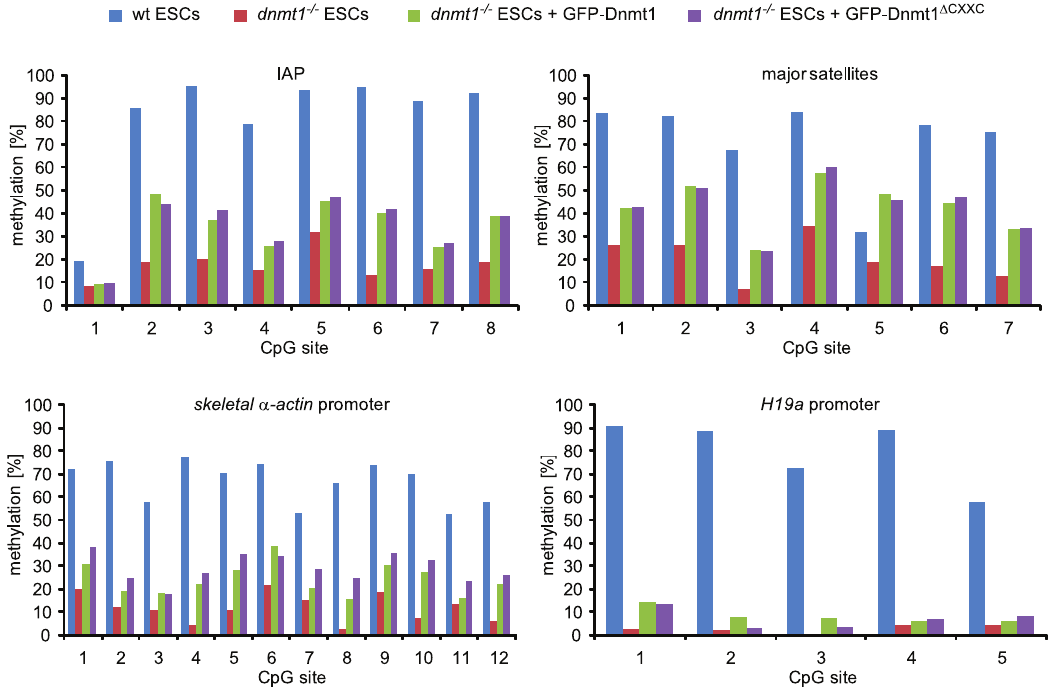
Figure 6. The CXXC deletion construct of Dnmt1 restores methylation in dnmt1 null cells. Mouse dnmt1 2 / 2 ESCs transiently expressing GFP-Dnmt1 or GFP-Dnmt1 D CXXC were isolated by FACS-sorting 48 h after transfection and CpG methylation levels within the indicated sequences were analyzed by bisulfite treatment, PCR amplification and direct pyrosequencing. Methylation levels of untransfected wild type and dnmt1 2 / 2 ESCs are shown for